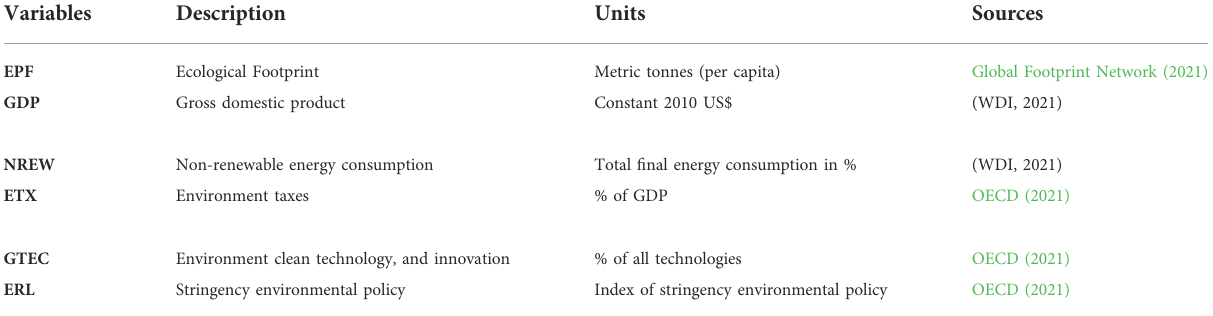
TABLE 1 List of